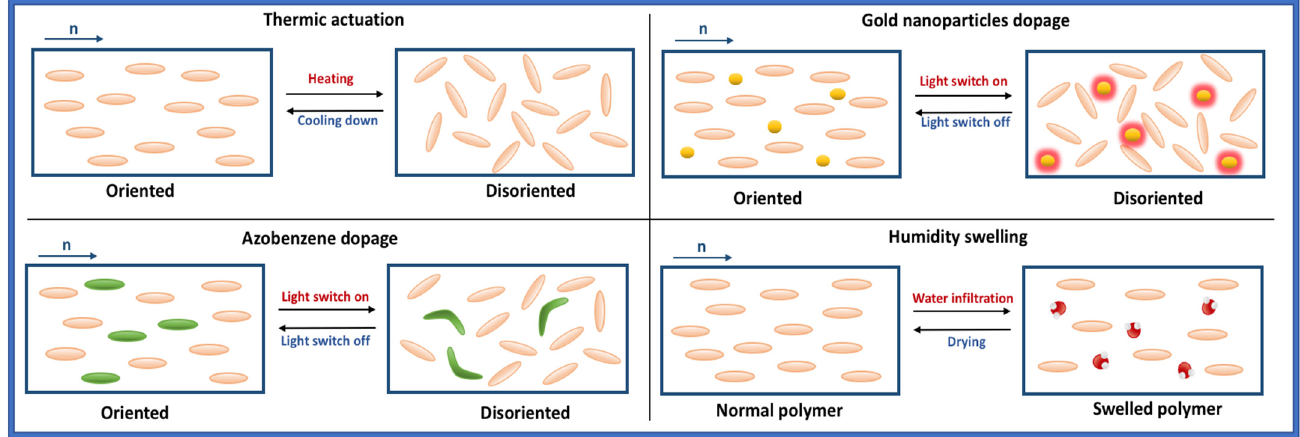
Figure 3. Existing actuation methods with a thermal, light, or humidity stimulus.